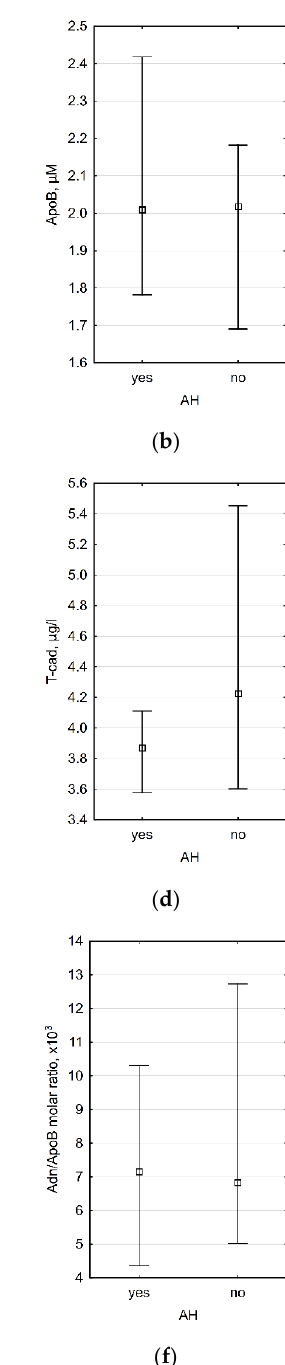
Figure 2. Association between presence of AH and ( a ) plasma LDL level ( p = 0.609), ( b ) plasma ApoB level ( p = 0.668), ( c ) plasma HMW adiponectin level ( p = 0.779), ( d ) plasma T-cadherin level (0.181), ( e ) HMW adiponectin/LDL molar ratio (0.961), and ( f ) HMW adiponectin/ApoB molar ratio ( p = 0.779). n = 35 for all